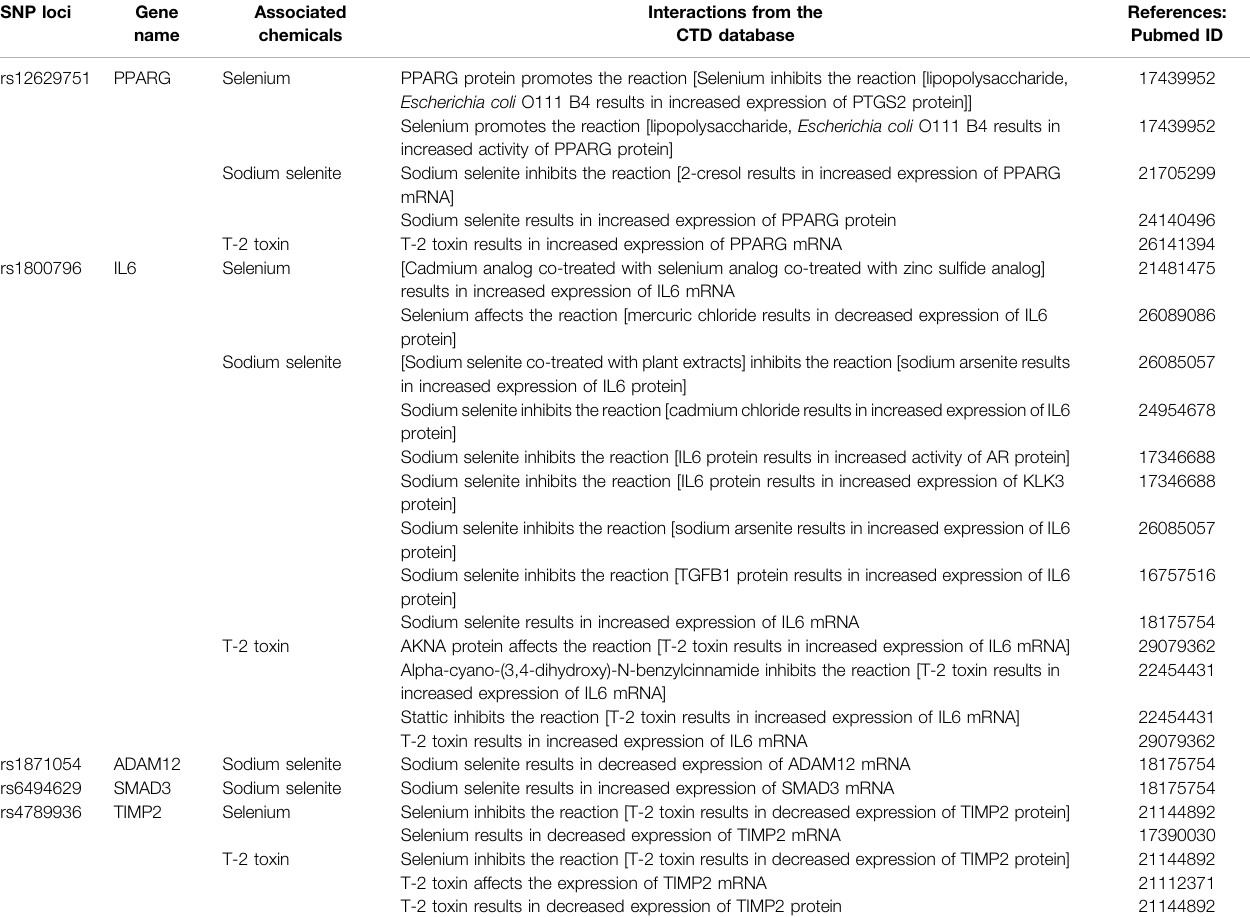
TABLE 5 | Candidate SNP loci corresponding genes and associated interactions with selenium and T-2